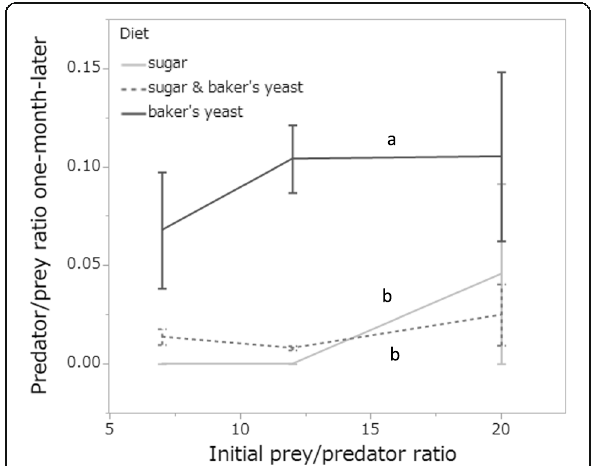
Fig. 3 Predator:prey ratio (mean ± SE) of mites after one month (30 days) of rearing on different diets at different initial predator:prey ratios. Same letters indicate that means are not significantly